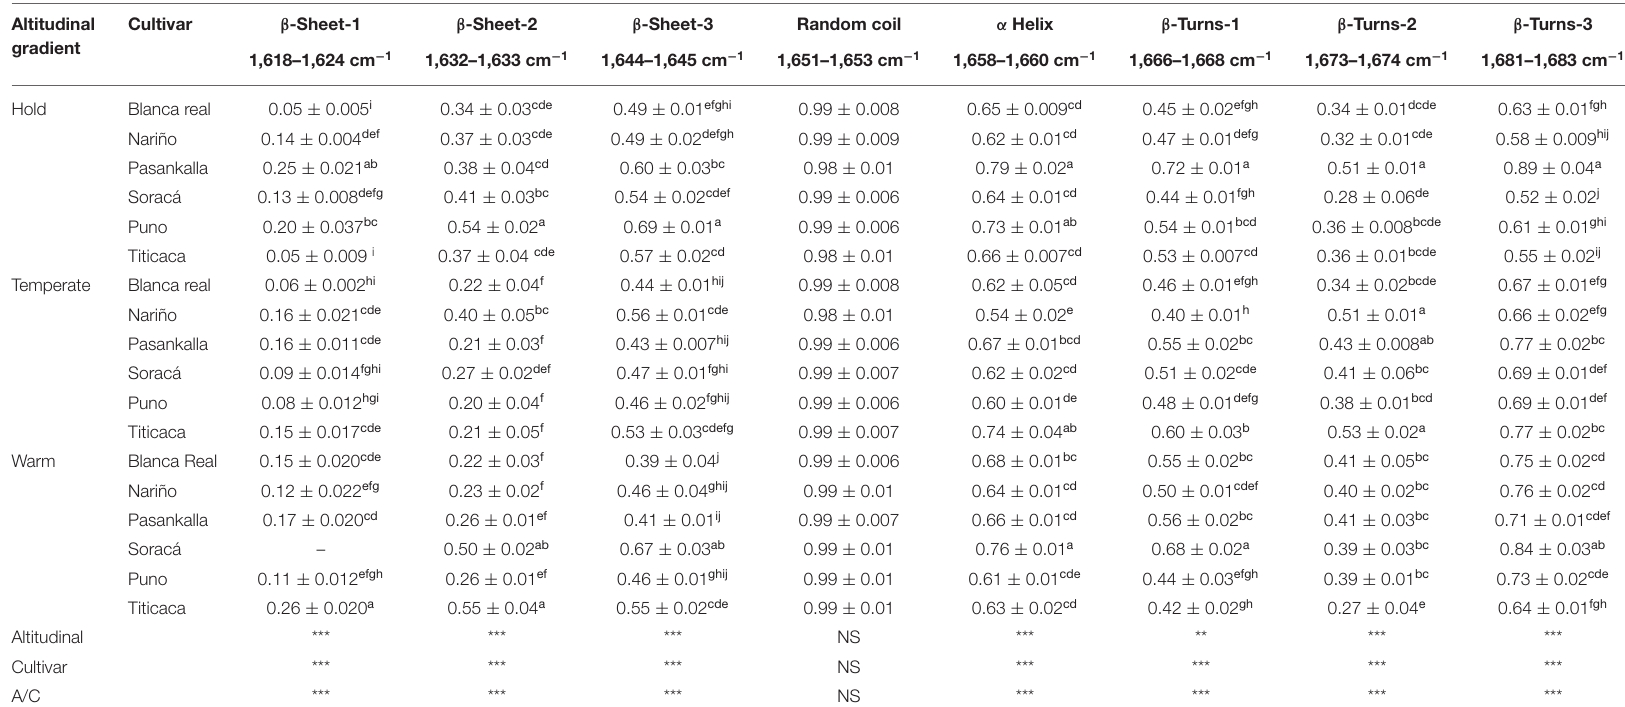
Results are expressed as the mean ± standard deviation (n = 3). Different letters indicate statistical differences, and asterisks indicate significant differences between treatments ( ** p < 0.01 and *** p < 0.001) by Tukey’s HSD